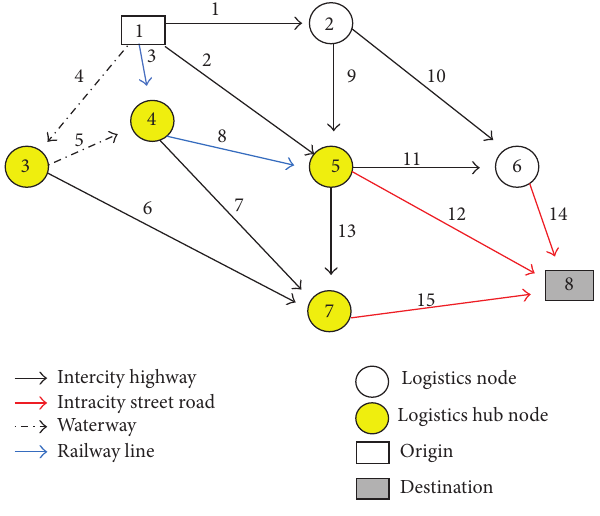
Figure 7: Effects of CO 2 emission taxes on logistics realized demand.